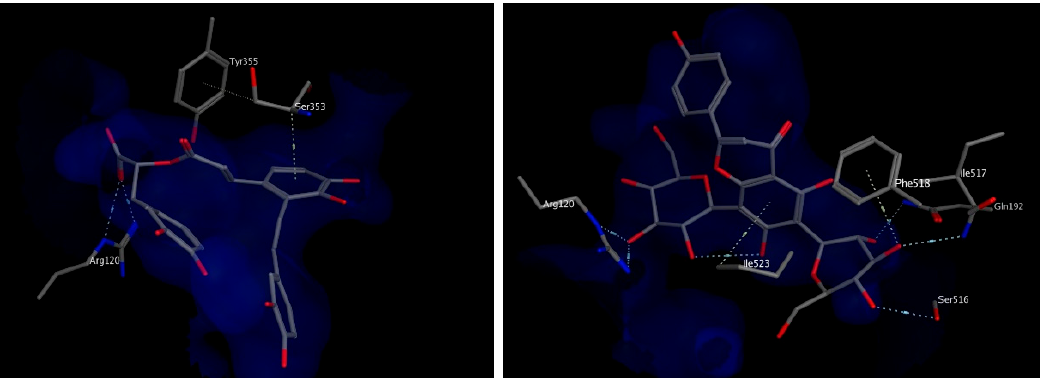
Figure 6. 3D view of interactions of salvianolic acid A ( left ) and apigenin 6,8-di-C-hexosides ( right ) with amino acid residues of COX-1. Side chains of amino acids were omitted for clarity, except for Ser353 (left) and Ile517 (right), whose backbones participate in hydrophobic interactions with the docked compounds.